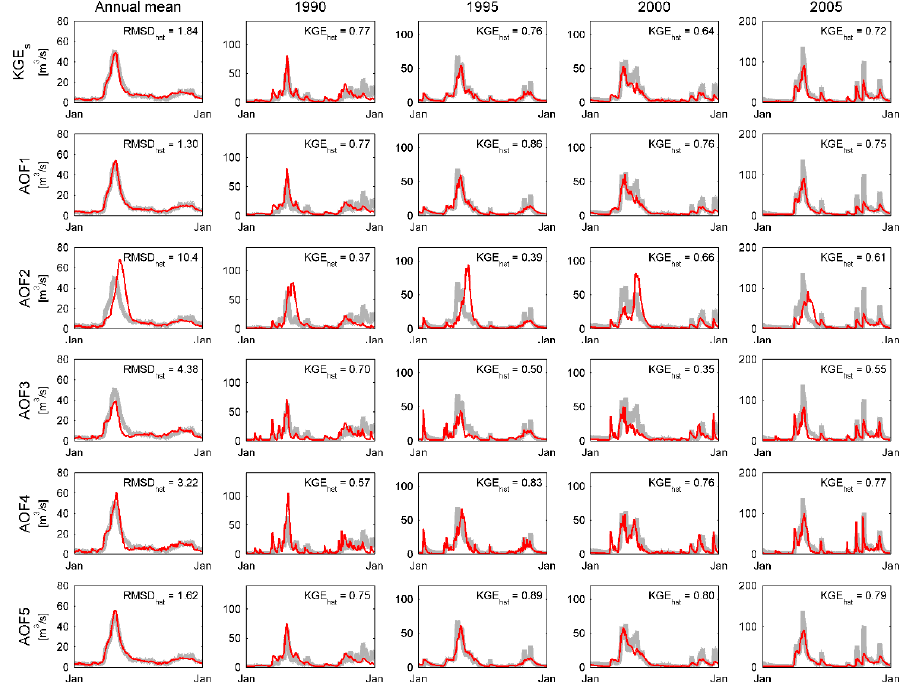
Figure 5. Observed (grey) and simulated (red) Du Loup River interannual and annual hydrographs (1990, 1995, 2000, and 2005, validation period). The WaSiM-ETH hydrologic model is forced and calibrated with historical meteorological observations (hst). Calibration is operated with a seasonal variation of the Kling-Gupta efficiency metric (KGE s ) and asynchronous objective functions AOF1 to AOF5 . Interannual performance is expressed in RMSD, annual performance, in KGE.